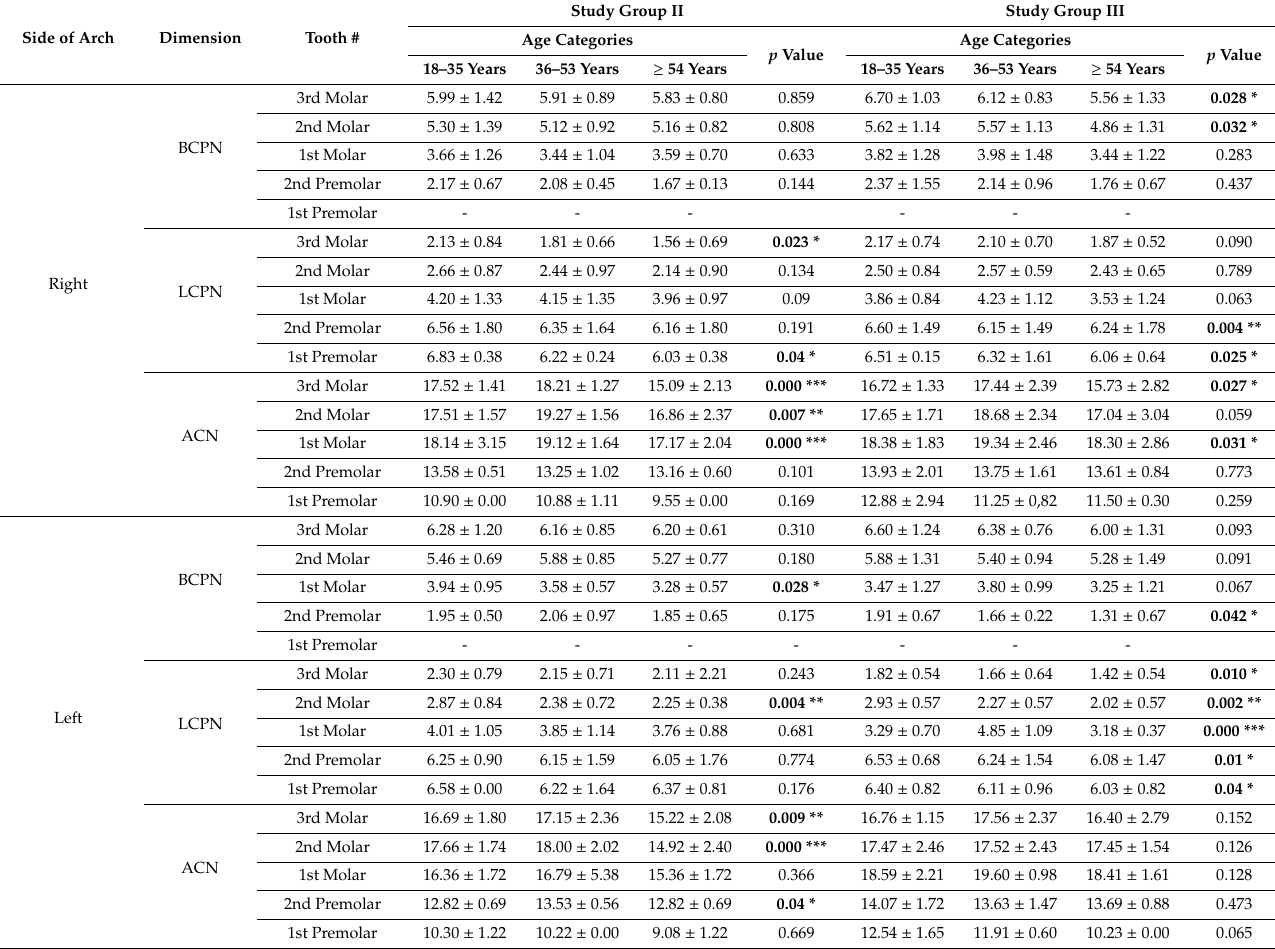
Table 4. BCPN, LCPN and ACN dimensions compared betweenthe age categories in study groups measured in millimeters (mm) and presented asmean ± SD. Side of